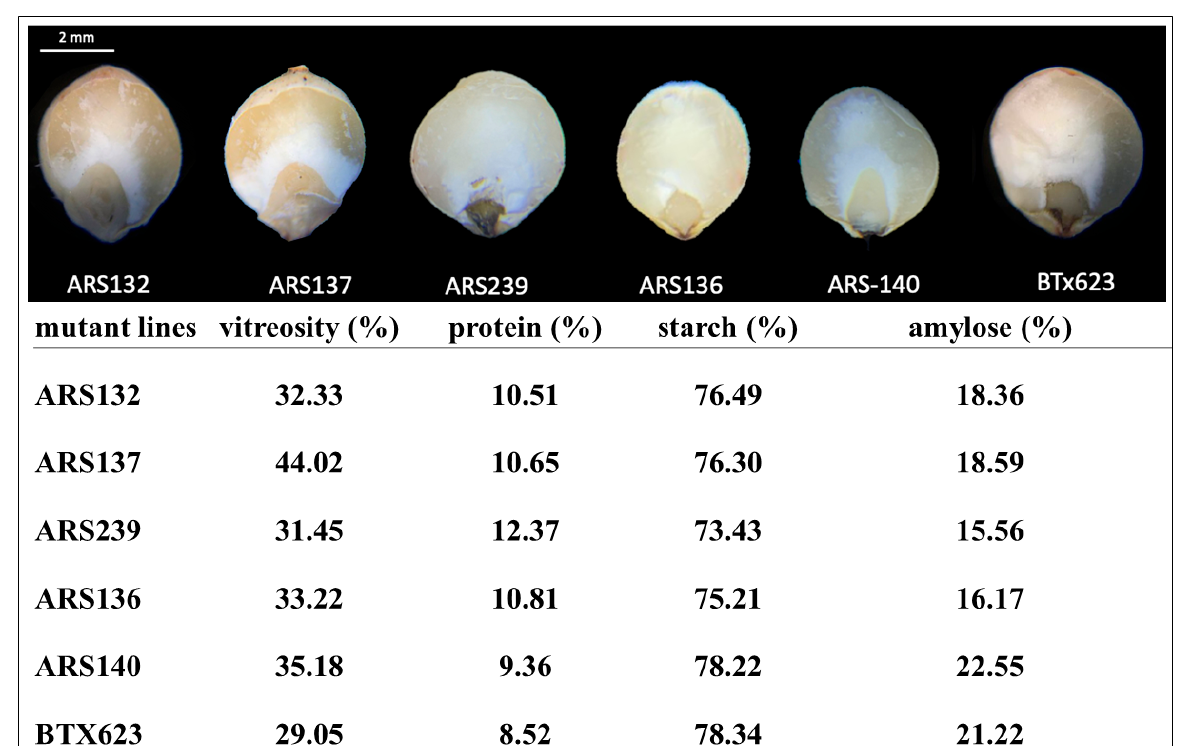
Figure 4. Variability in the kernel structure, composition, and starch content in five ethyl methanesulfonate (EMS) mutant sorghum lines and controls (BTx623).